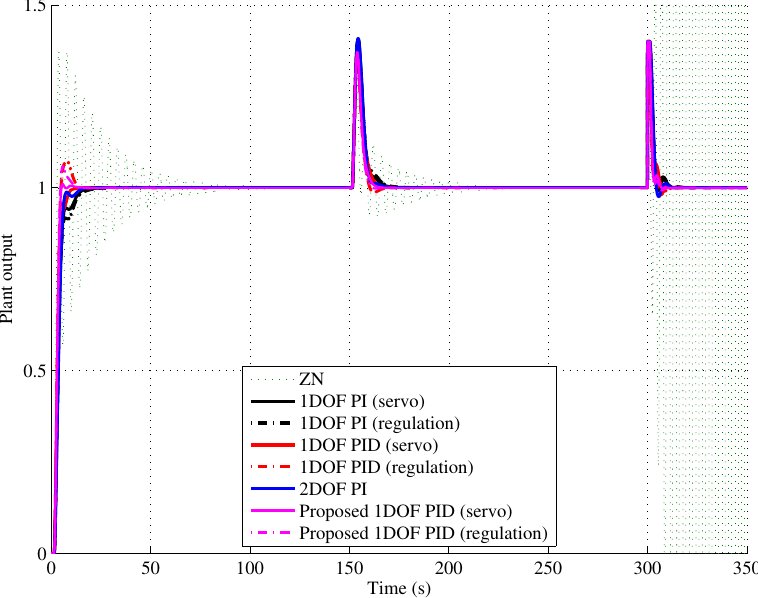
Figure 16. Plant outputs of the proposed and conventional